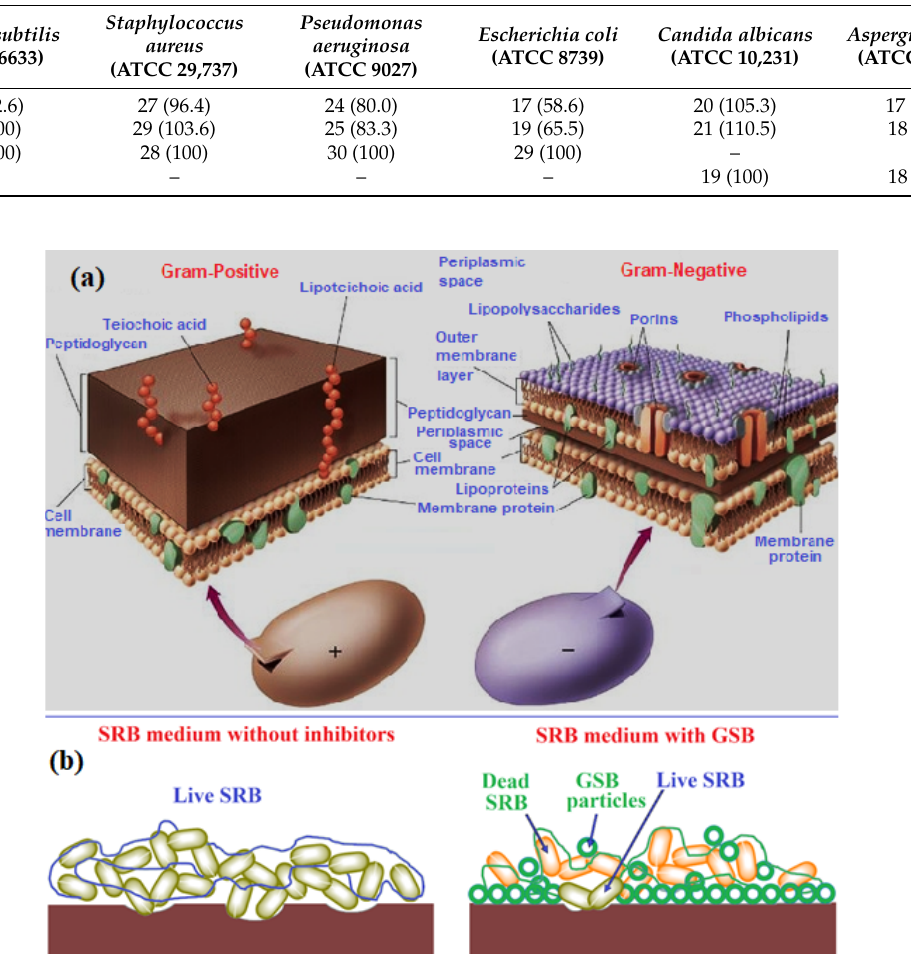
Figure 7. ( a ) Gram-positive and Gram-negative bacterial cell wall structure, ( b ) representative scheme for SRB inhibition process through GSB particles [64].